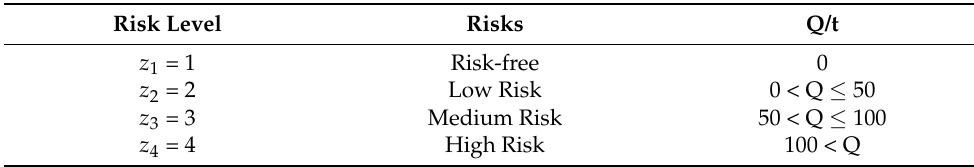
Table 2. Classification of gas outburst